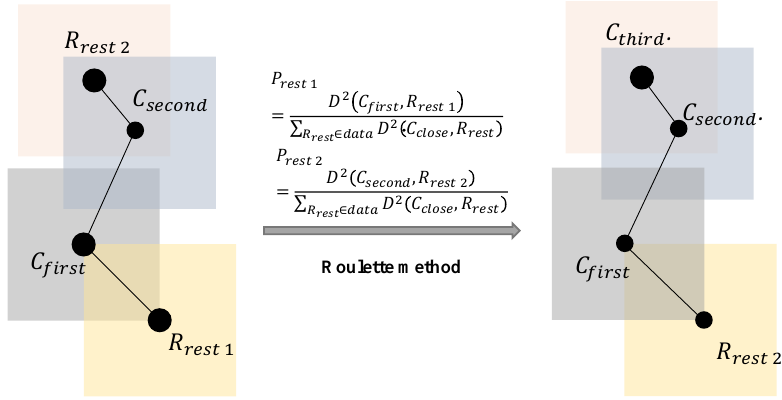
Figure 3. The process of generating subsequent cluster centers.